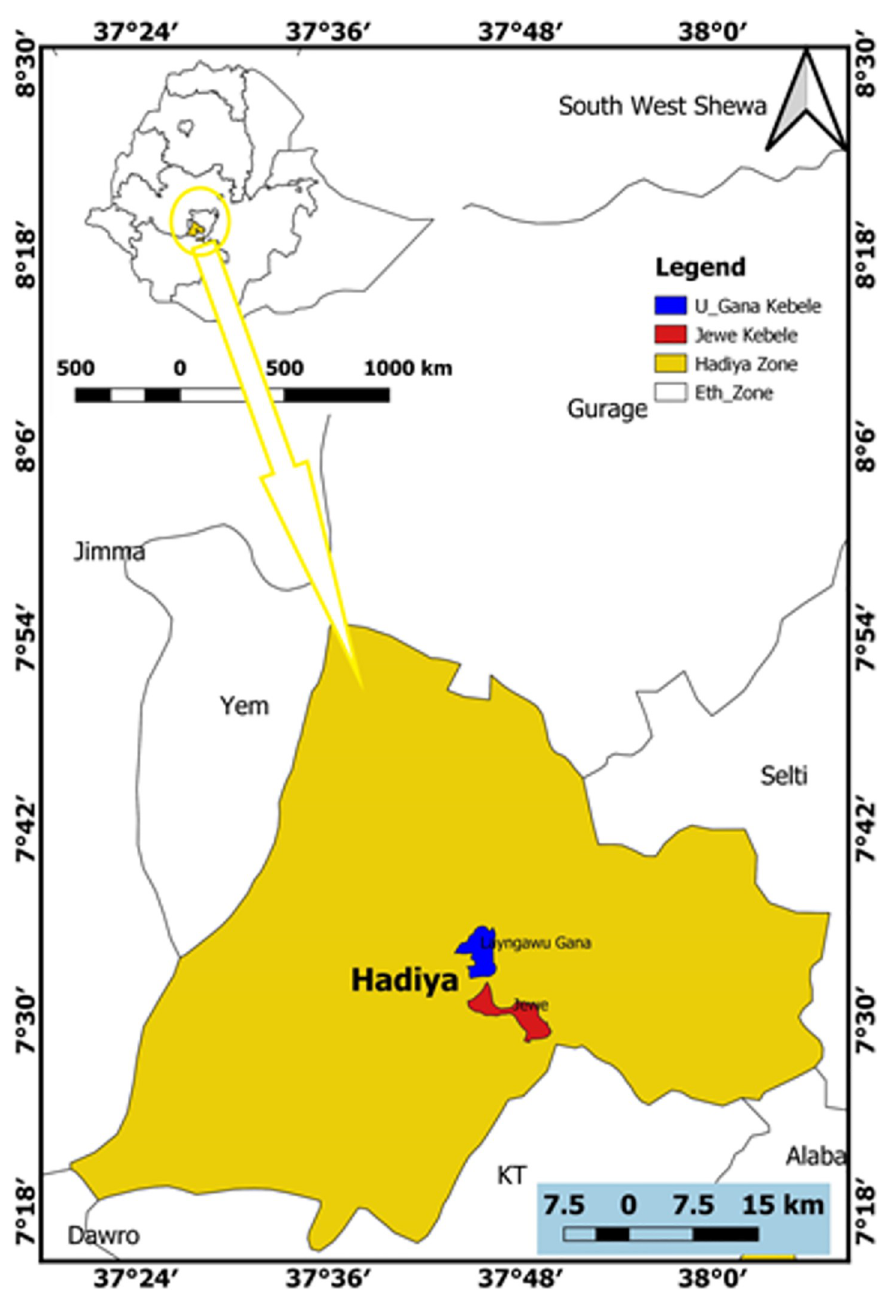
Fig 1. The location of the study area in Hadiya zone, Ethiopia. The shape files were accessed from open data sources of the open AFRICA https://open.africa/dataset/africa-shapefiles), http://geoportal.icpac.net/layers/geonode%3Aafr_ g2014_2013_0 (Open